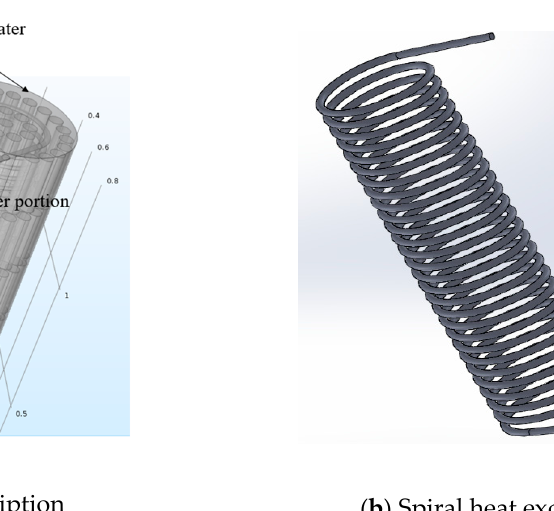
Figure 1. System schematic diagram.